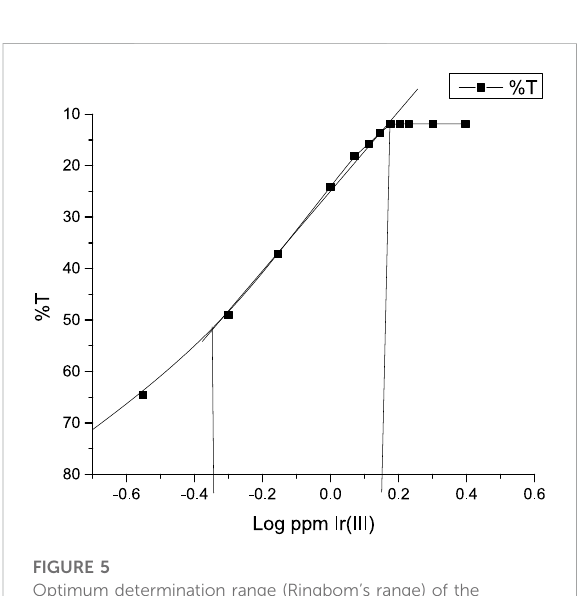
FIGURE 5 Optimum determination range (Ringbom ’ s range) of the complex at a wavelength of 415 nm Ir (III)-CHMTB